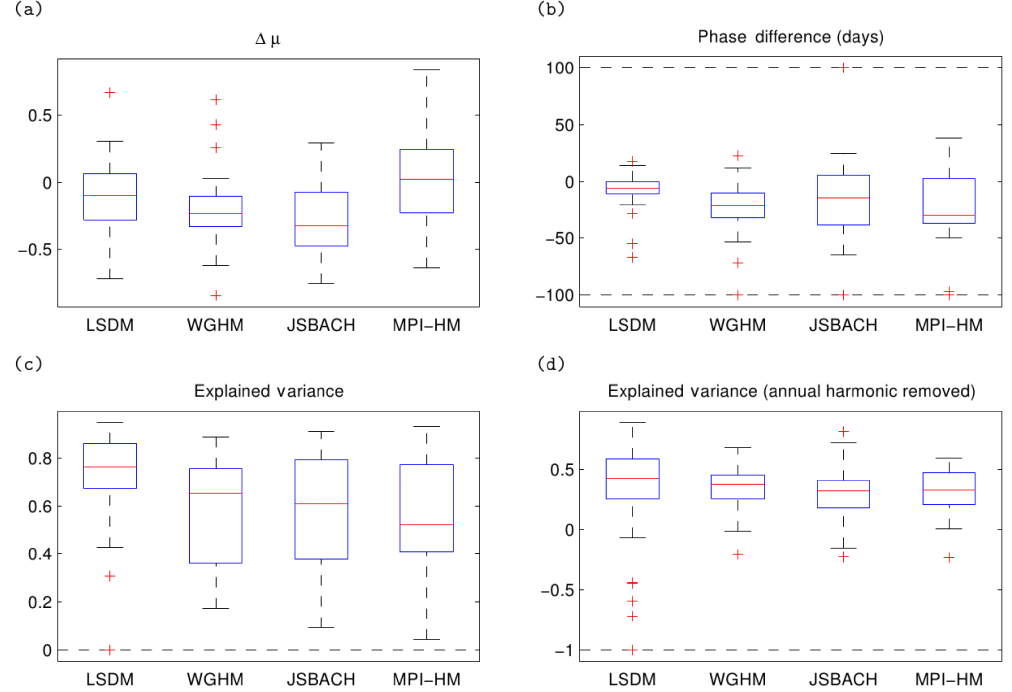
Figure 8. Box plots illustrating the (cid:49)µ (a) , phase differences (b) , explained variance and (c) explained variance with the annual harmonic signal removed (d) for the TWS from GRACE and models. The red horizontal line is the median, the edges of the box are the 25th and 75th percentiles, the whiskers extend to the most extreme data points not considered outliers, and outliers are plotted individually and set within the extreme data limits as indicated by the dashed